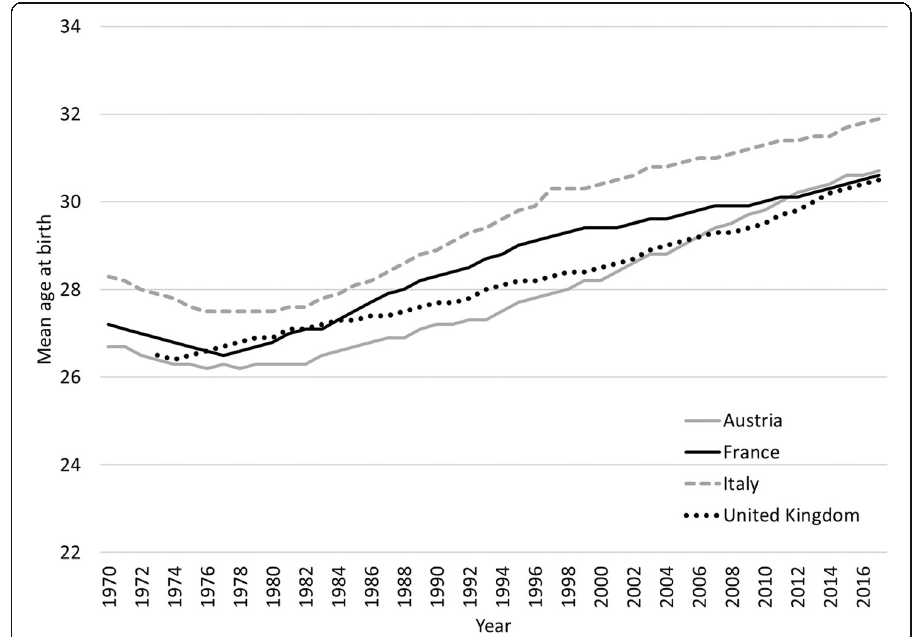
Fig. 1 Mean age at birth in four European countries since 1970. Source: Eurostat